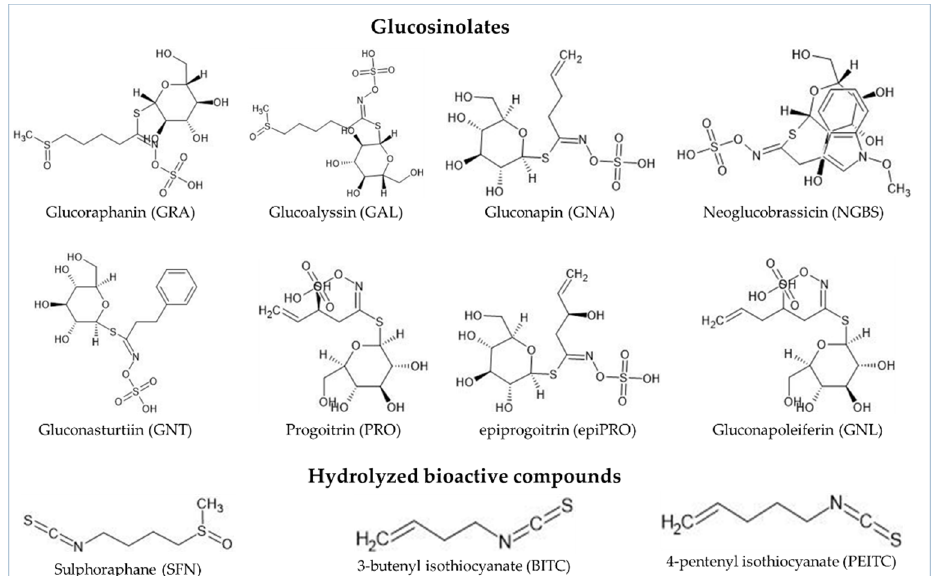
Figure 1. Chemical structure of glucosinolates and hydrolyzed bioactive compounds. Structure was drawn in ChemSketch software using smile notation from ChemSpider (www.chemspider.com (accessed on 7 June 2021)) database.